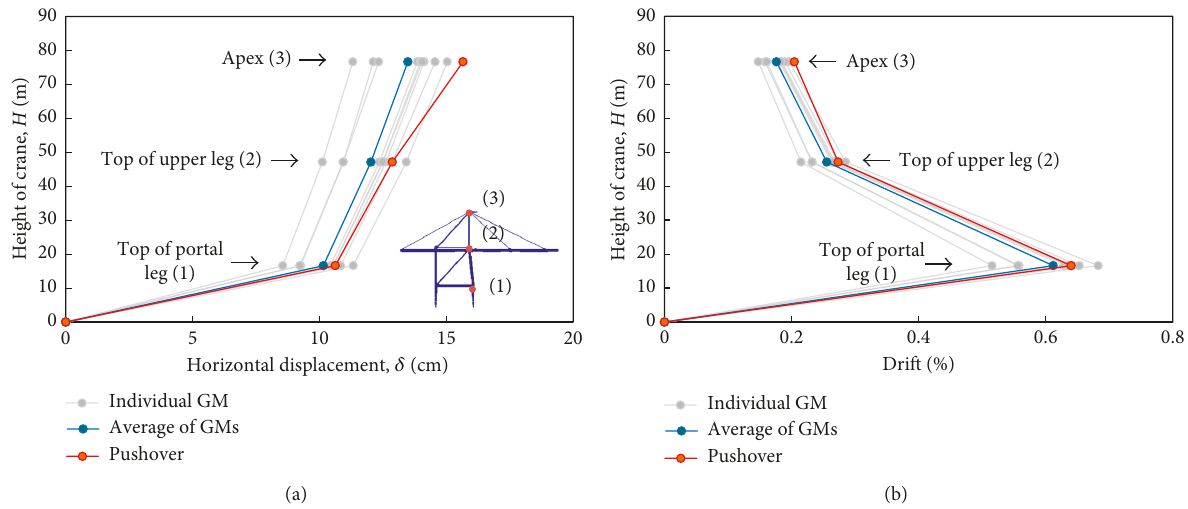
Figure 10: Height of crane versus (a) horizontal displacement and (b) drift.